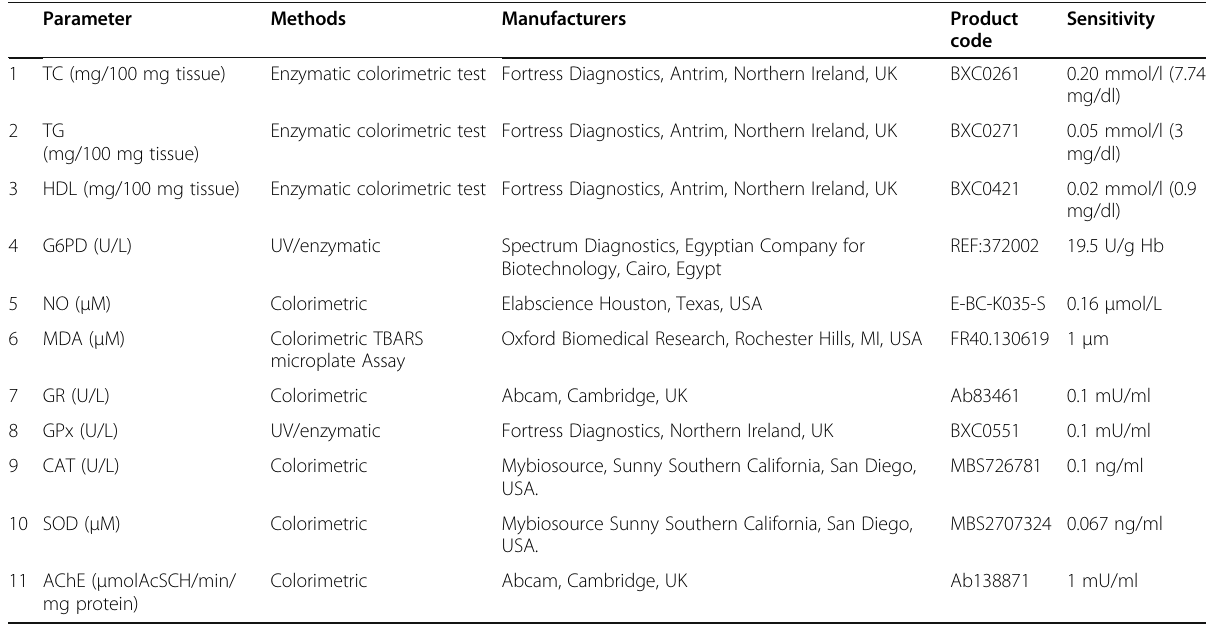
Table 1 Product information on biochemical assays